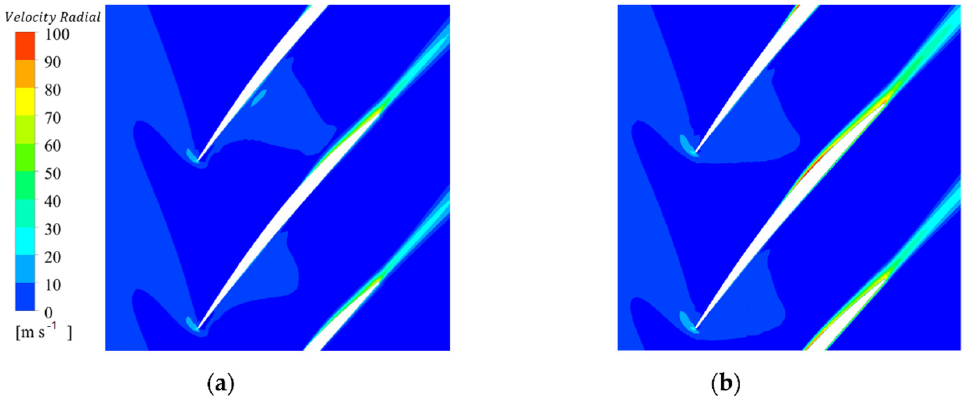
Figure 25. Comparison of the radial velocity of B2B views at 60% spanwise location. ( a ) DIS case; ( b ) COUP